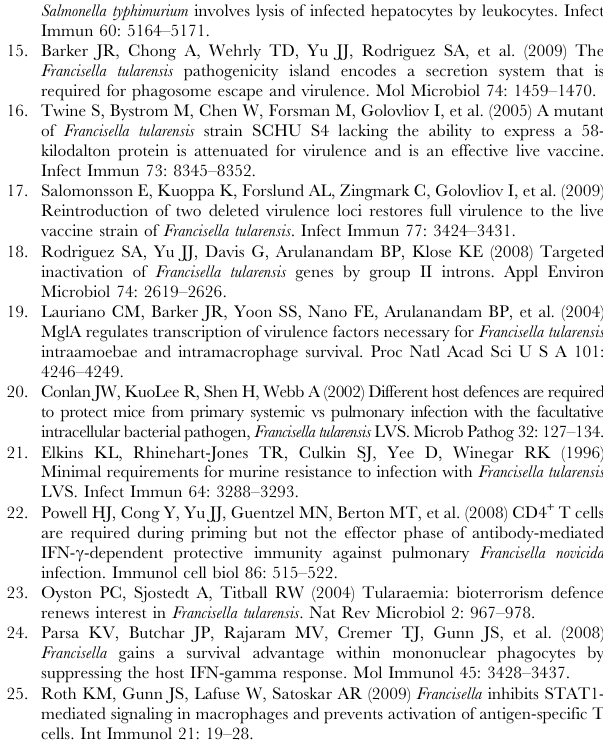
Table S3 Proteins identified in the culture supernatant of the fopC mutant. The fopC mutant was grown in Chamberlain’s medium for 36 h. Culture filtrate was concentrated using 10,000 MW cut-off Centripreps, digested with trypsin, and subjected to proteomic analysis using Matrix Assisted Laser Desorption/ Ionization-Time of Flight mass spectrometry. Each of the identified proteins in this list contains at least 5 matched peptide